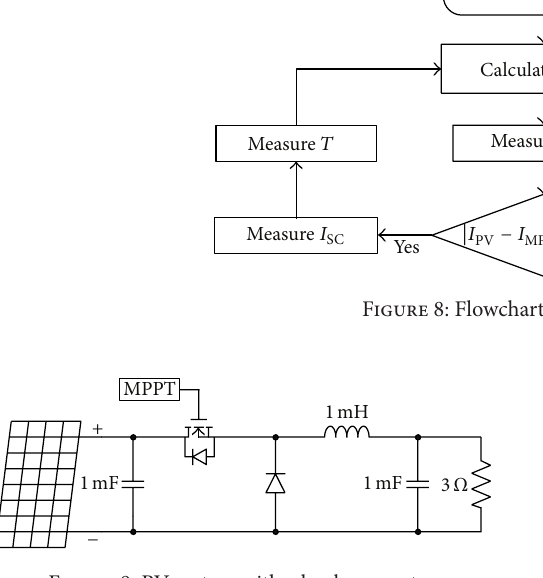
Figure 9: PV system with a buck converter.